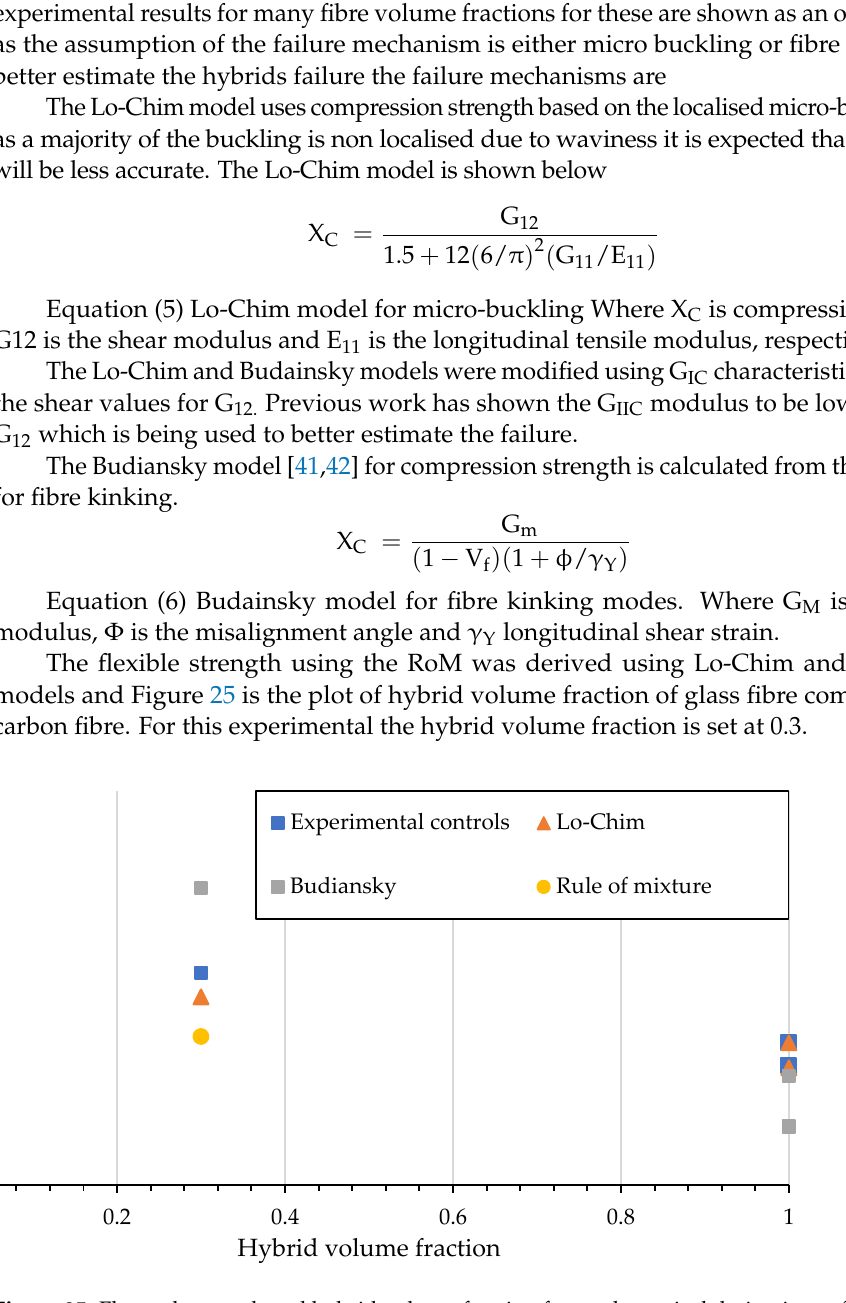
Figure 25. Flexural strength and hybrid volume fraction for mathematical derivations of the Lo-Chim and Budiansky models, compared with the experimentally produced CF, GF and GGCC samples and their veil toughened counterparts CFT, GFT and GGTCC.